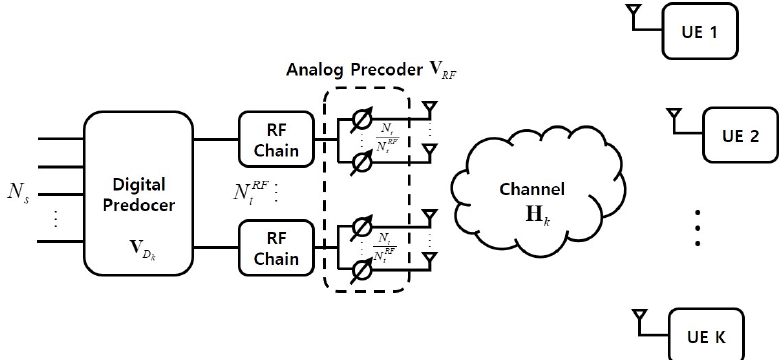
Figure 2. The architecture of partially connected structure hybrid beamforming